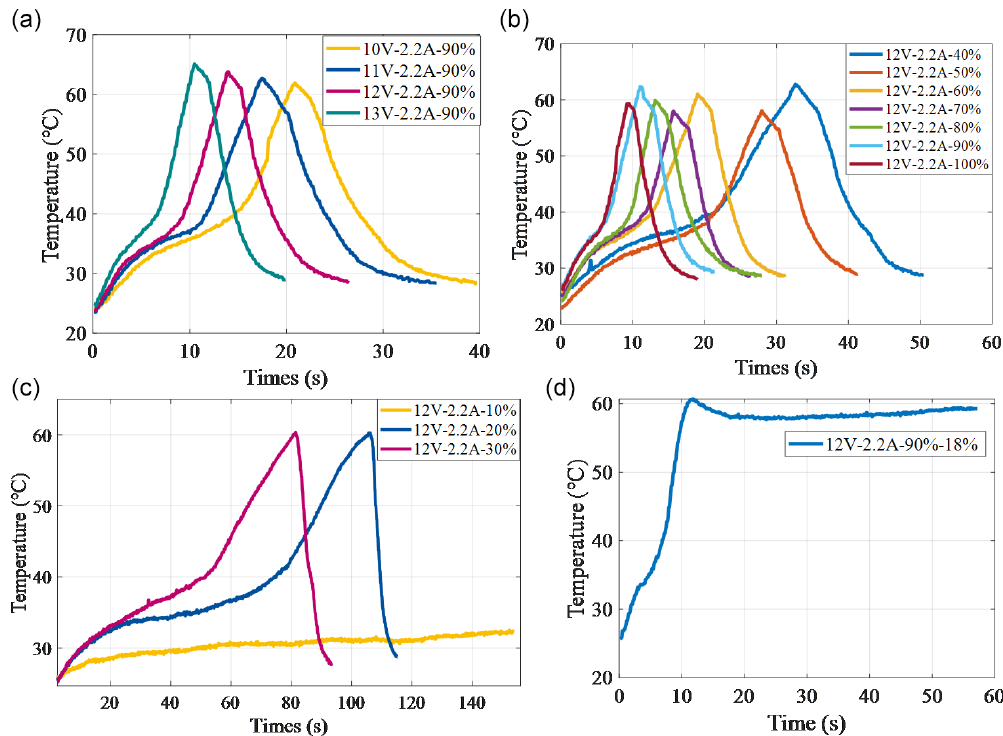
Figure 9. The temperature change of the SMA spring (a) under different voltages, (b, c) under different duty cycles, and (d) when maintaining a constant temperature.